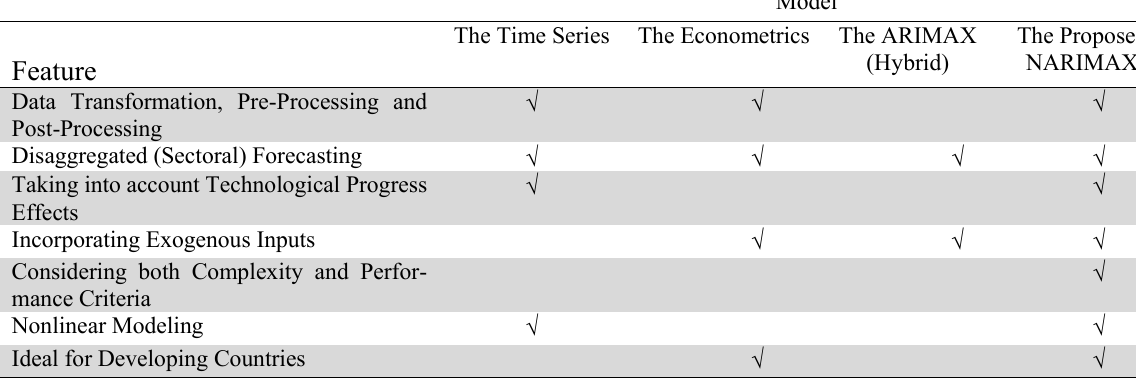
The Time Series The Econometrics The ARIMAX